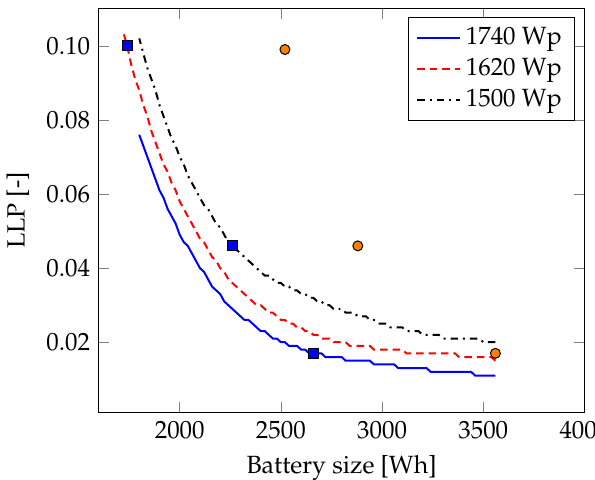
Figure 16. Variations in average LLP per household over battery size for a homogeneous tier 4 microgrid with 20 households. The points marked correspond to the different battery sizes for the standalone (circular orange dots) and microgrid case (blue rectangles),